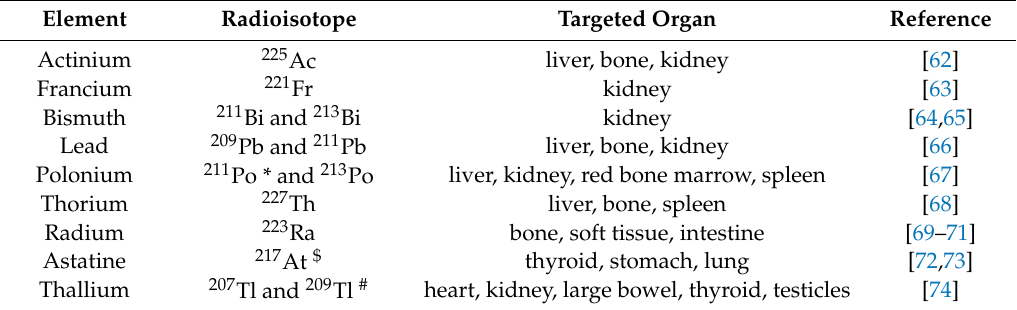
* Probability of only ≈ 0.3% in the decay chain of 227 Th; $ With a half-life of only 32 msec, the accumulation of 217 At could not be proven in these organs but is assumed to be similar to that of other astatine isotopes; # Probability of only ≈ 2% in the decay chain of 225 Ac.